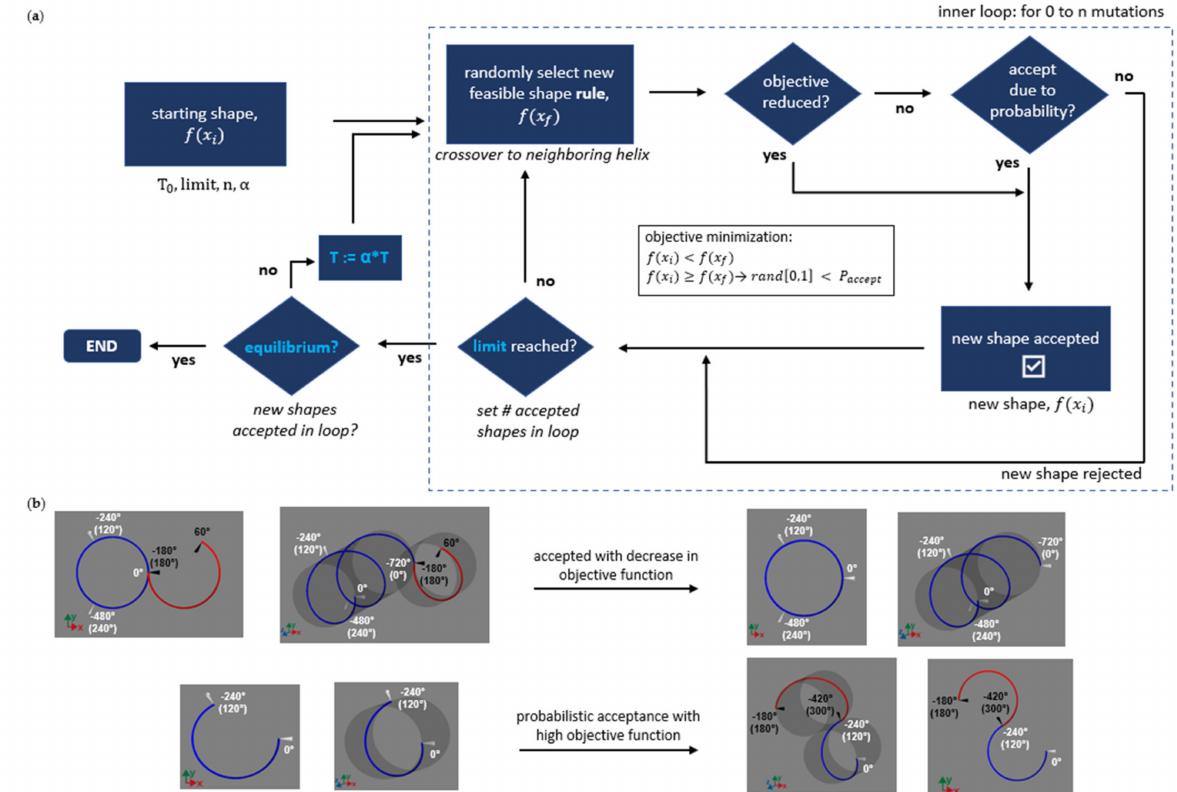
Figure 4. Shape annealing algorithm for scaffold routing when constrained to a honeycomb lattice architecture. Key steps are initializing the temperature, verifying desired goal with metropolis function, checking whether the limit and equilibrium has been reached, and reducing the temperature. Key parameters are the temperature (T), mutations (n), limit, and reduction factor ( α ): ( a ) General flowchart of the shape annealing algorithm.; ( b ) Two examples of rule applications based on objective minimization. The top example shows the shape rule 3 (reversal rule) accepted with a decrease in objective function. The bottom example shows the shape rule 1 (additive rule) accepted with a probability due to an increase in objective